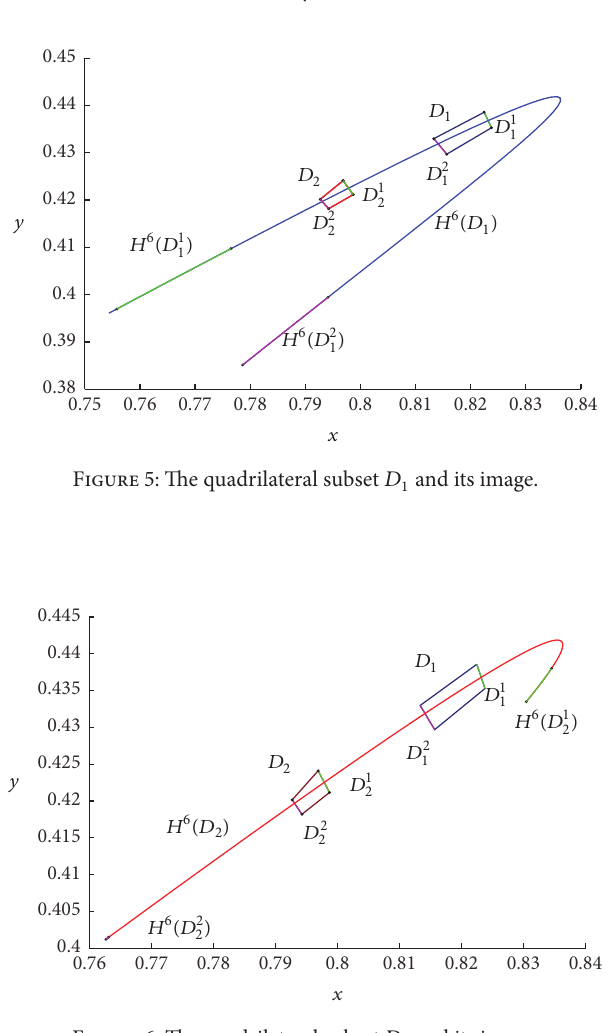
Figure 6: The quadrilateral subset 𝐷 2 and its